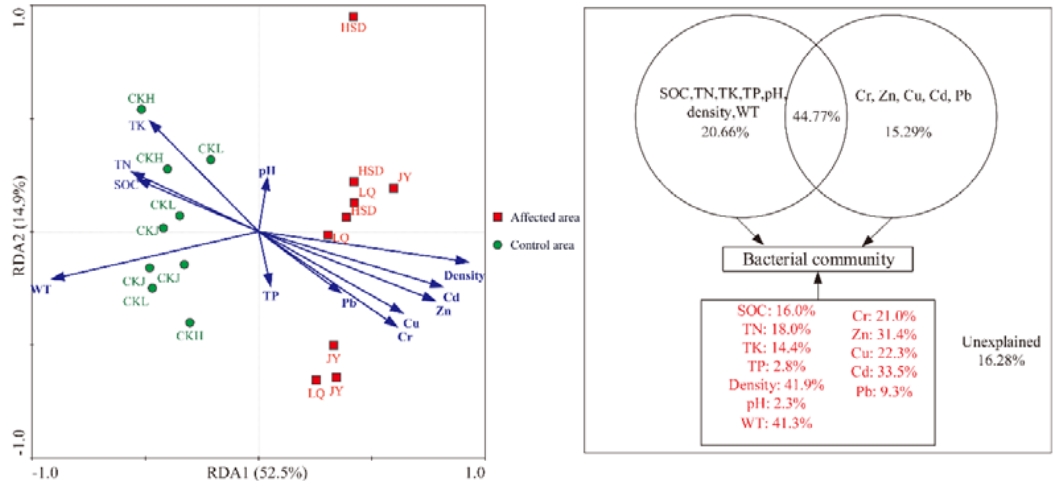
Figure 6. Redundancy analysis (RDA) of the bacterial community compositions and various environmental factors and variation partition analysis of the effects of twelve factors.